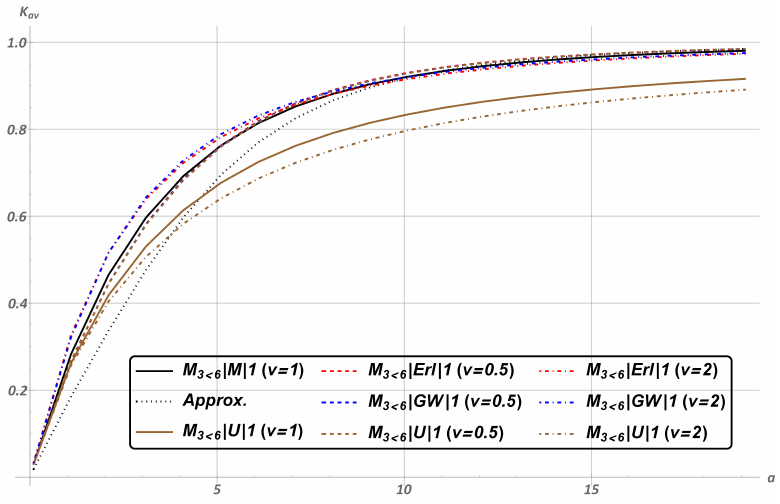
Figure 5. K av of a 3-out-of-6 system under the rare failures’ scenario with different repair time distributions B ( t ) and coefficients of variation v .